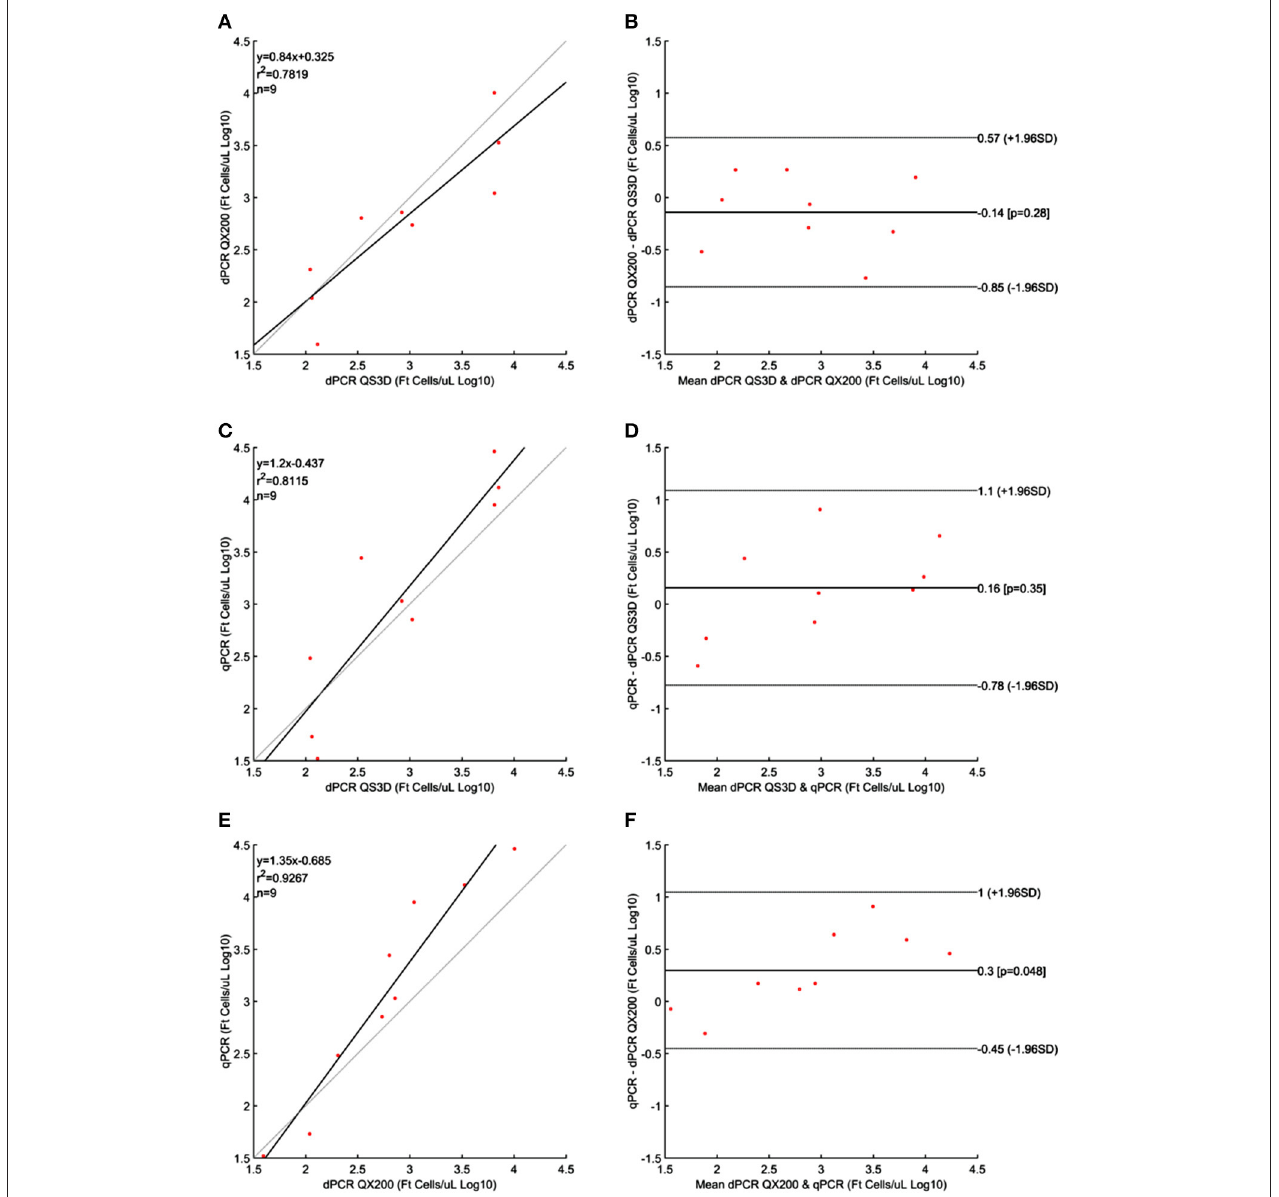
FIGURE 4 | Linear regressions and Bland and Altman analyses of F. tularensis (Ft) cells in unknown samples obtained by dPCRs (QuantStudio 3D and QX200) and qPCR. (A) Linear regression between the two dPCRs; (B) Bland and Altman analysis between the two dPCRs; (C) Linear regression of dPCR QuantStudio 3D and qPCR; (D) Bland and Altman analysis of dPCR QuantStudio 3D and qPCR; (E) Linear regression of dPCR QX200 and qPCR; (F) Bland and Altman analysis of dPCR QX200 and qPCR. Data were reported as Log 10 cells per µ L. The gray lines in linear regression plots represent the ideal regression